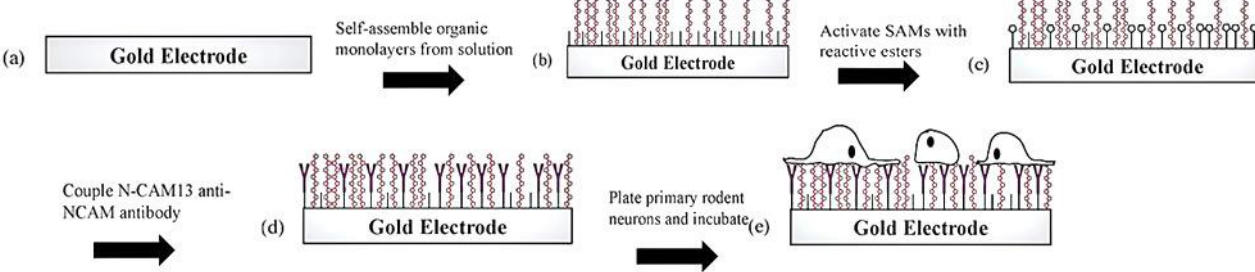
Figure 1. Assembly schematic for SAM-based neuron/electrode interface ( a , b ) Formation of mixed EHPT/MHA SAM by incubation in organic thiol solution; ( c ) formation of reactive NHS esters on MHA carboxyl groups; ( d ) capture of adhesion-promoting biomolecules (N-CAM13 anti-NCAM) by NHS ester reaction with free amino groups; ( e ) quenching of unreacted esters and plating of primary neurons that bind to the coupled adhesion molecules [44].